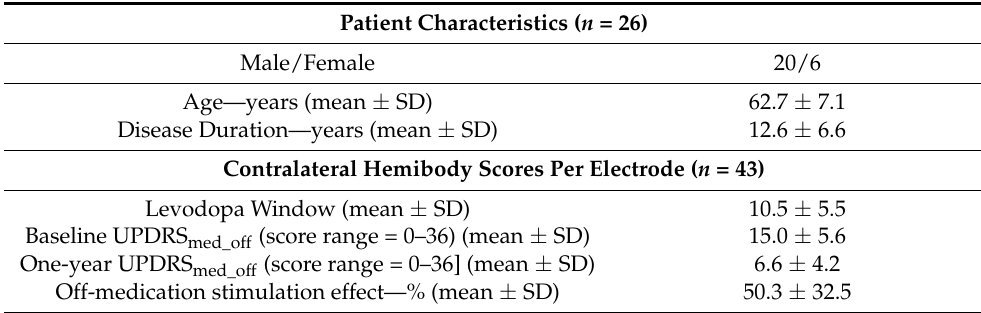
Table 1. Clinical characteristics of the patients (top) and the contralateral hemibody scores per electrode (bottom).